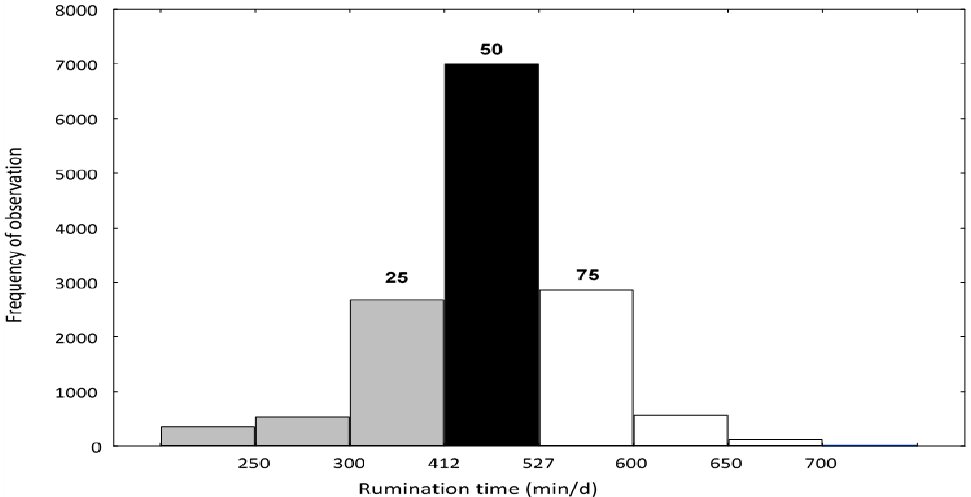
Figure 1. Frequency distribution of cows divided based on rumination time (min/day). Low rumination (L, grey color) to 412 min/day, medium rumination (M, black color) from 412 to 527 min/day, and high rumination (H, white color) from 527 min/day.